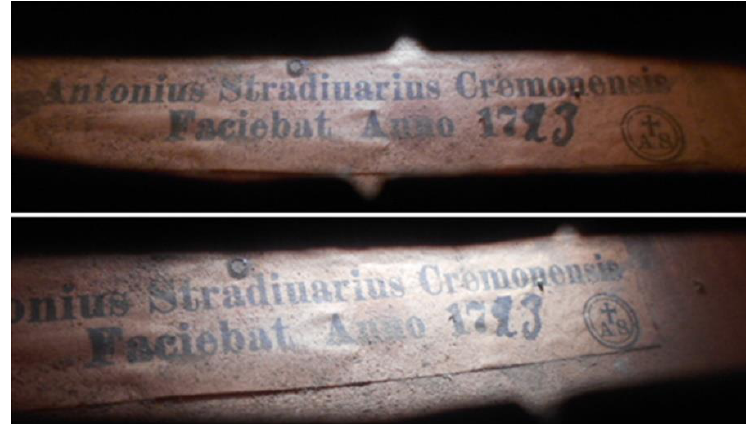
Figure 4. Images of the label, highlighting the loose contour and the alveoli.